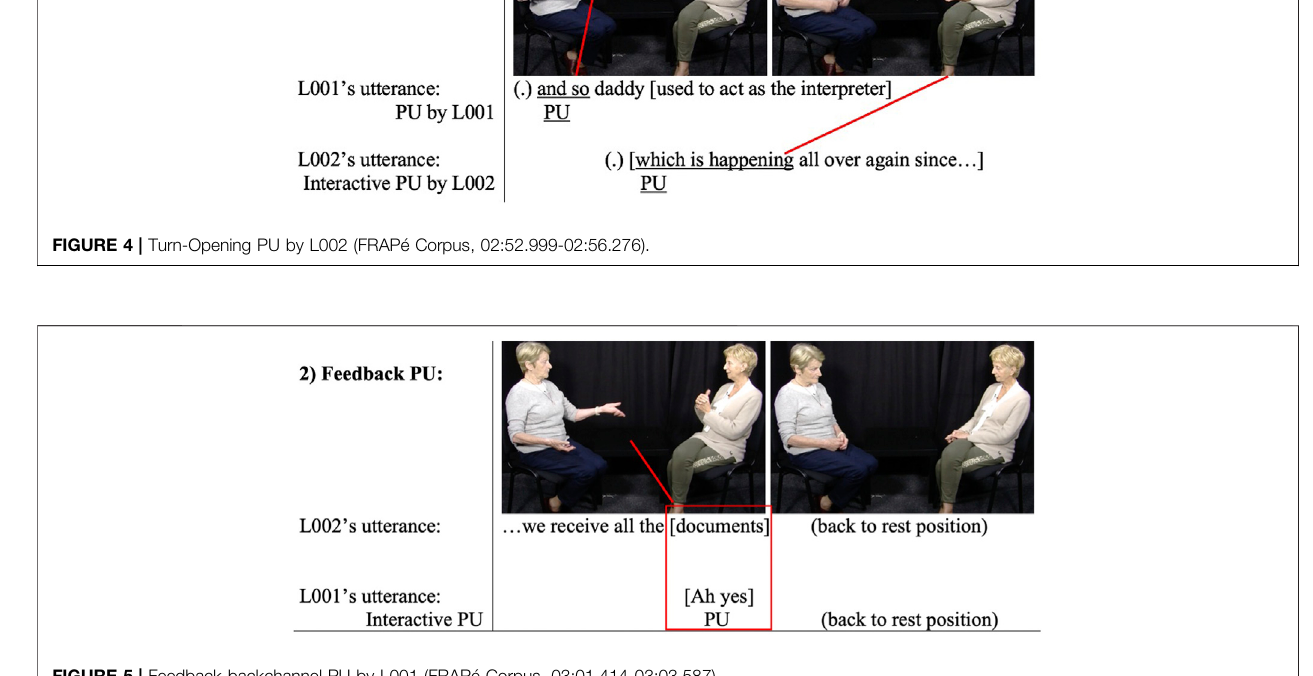
FIGURE 5 | Feedback backchannel PU by L001 (FRAPé Corpus, 03:01.414-03:03.587).